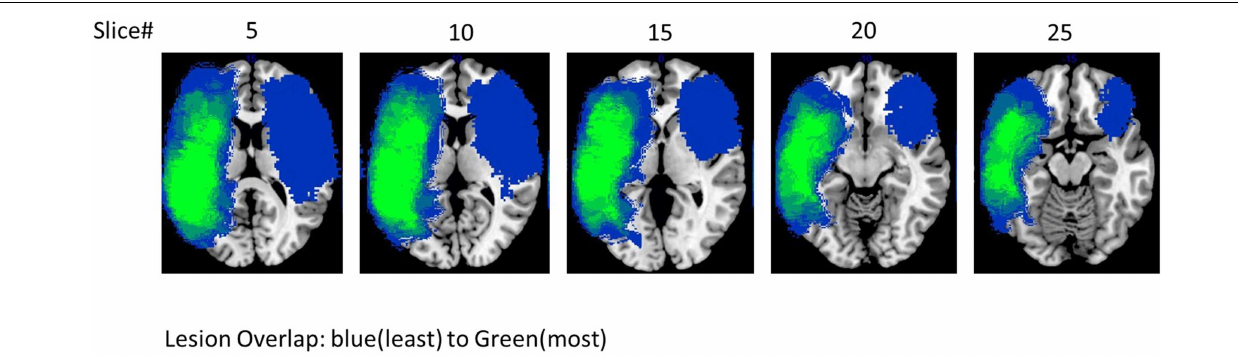
FIGURE 1 | Lesion overlap of all the eight